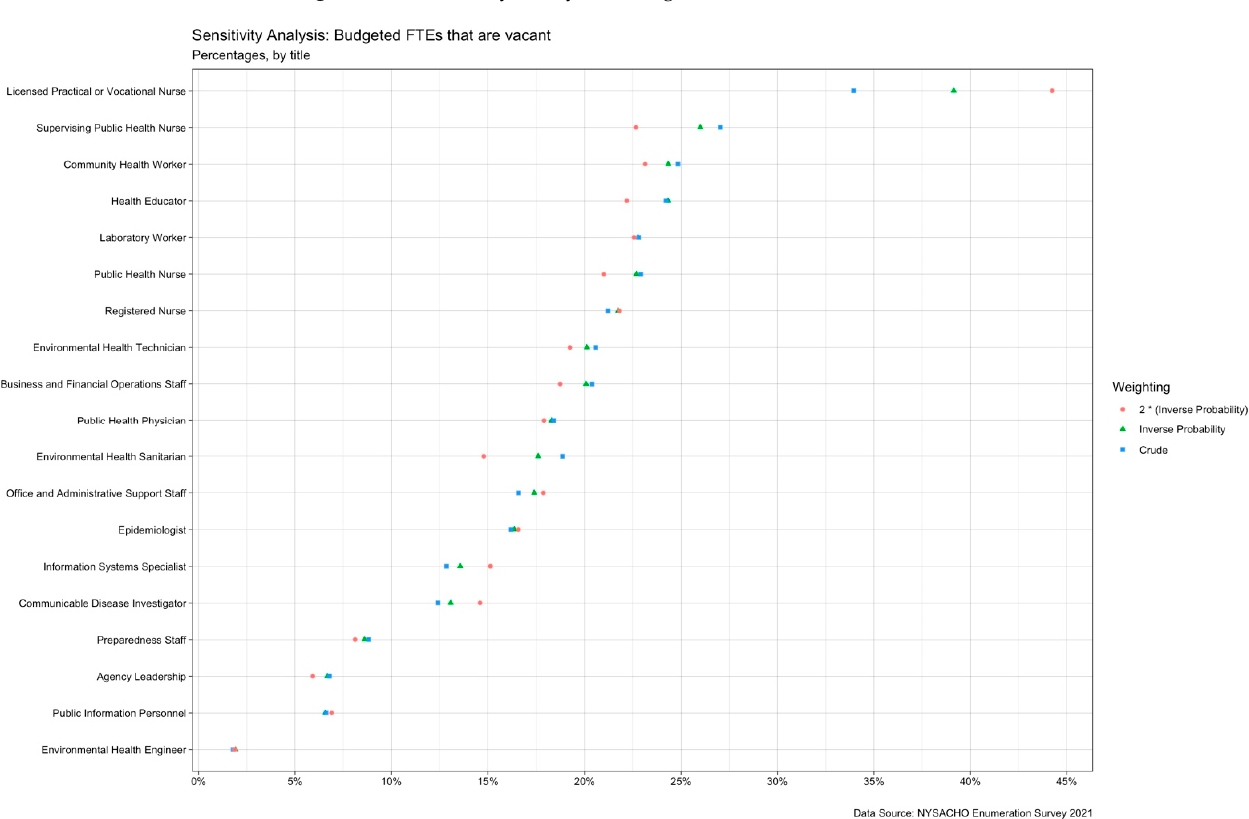
Figure A3. Sensitivity Analysis for Figure